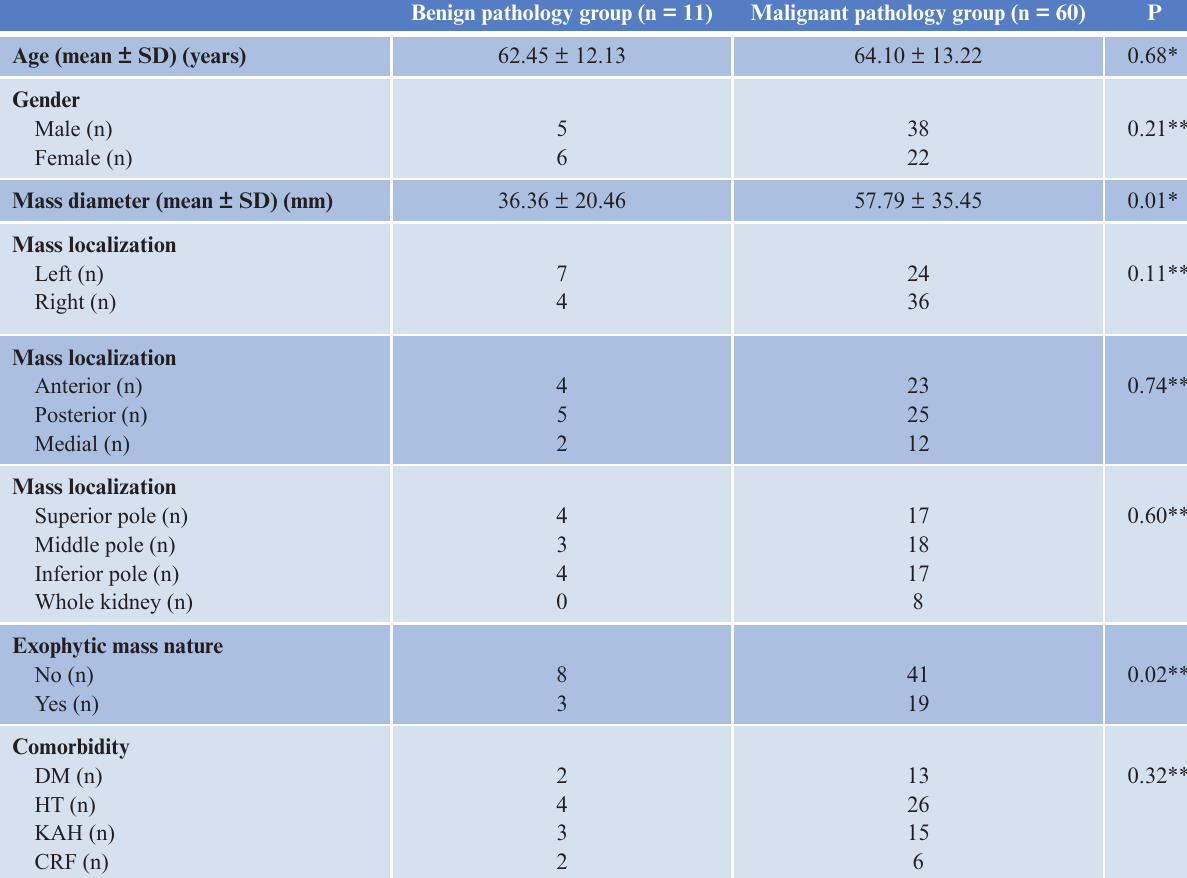
Table 1: Patients and mass characteristics of the